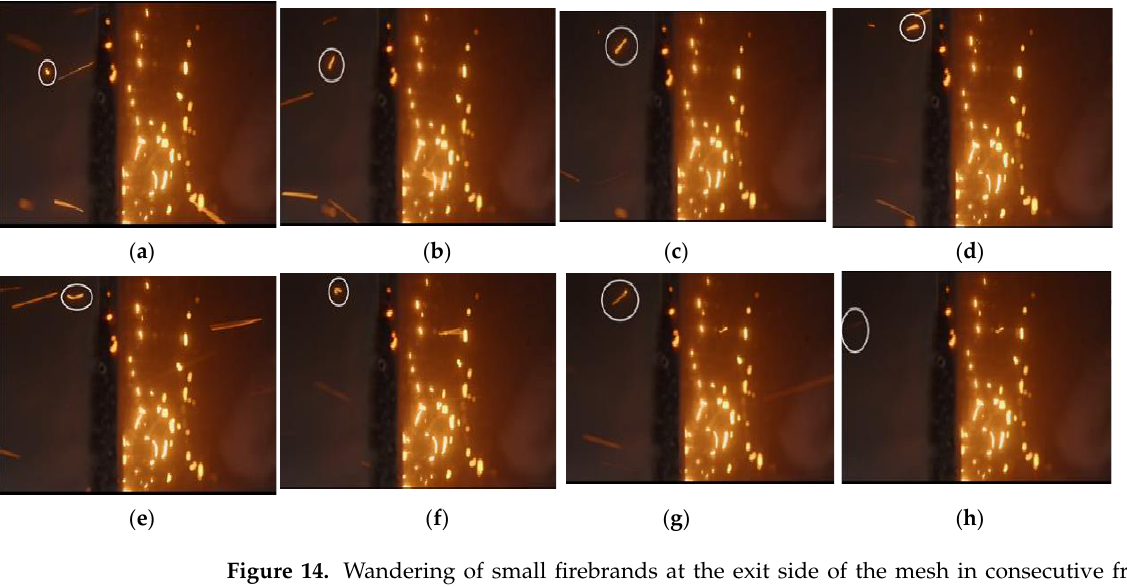
Figure 14. The slipping firebrands, ( a ) a firebrand at hitting point, ( b ) the firebrand slipped and changed and became a pausing firebrand, ( c ) an approaching firebrand, ( d ) the slippage of the